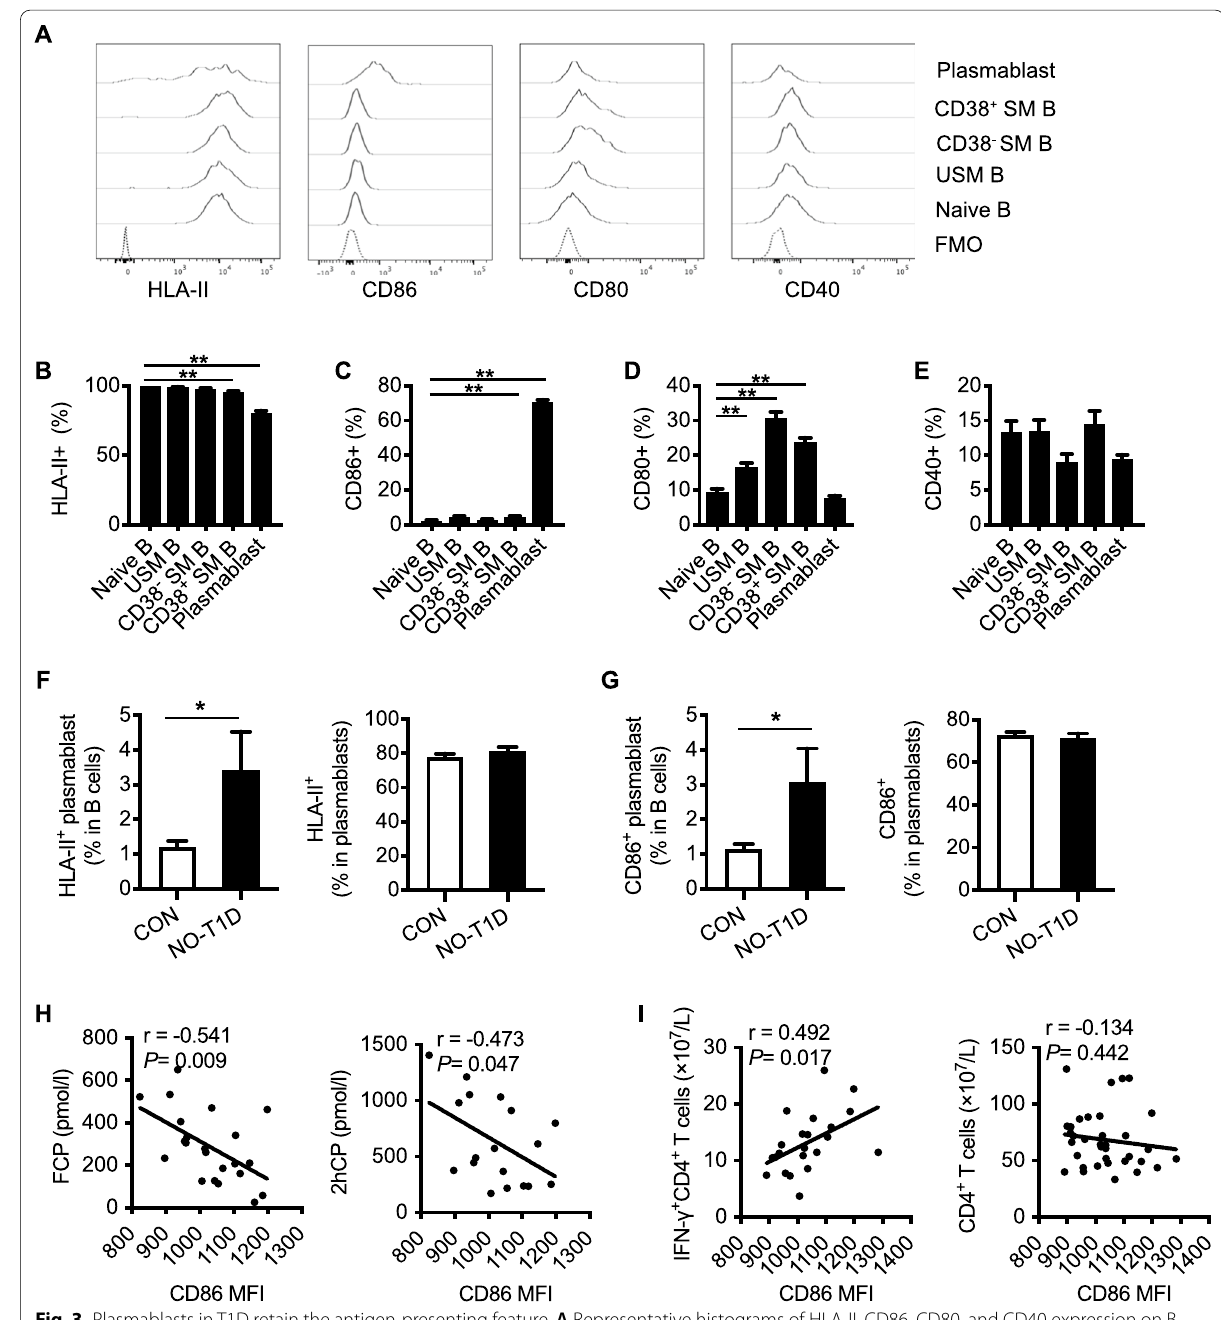
Fig. 3 Plasmablasts in T1D retain the antigen-presenting feature. A Representative histograms of HLA-II, CD86, CD80, and CD40 expression on B cell subsets from patients with new-onset T1D. B – E The analyses of the HLA-II, CD86, CD80, and CD40 expression on B cell subsets. Data indicate mean SEM. Difference between groups were assessed by One-way ANOVA followed by Dunnett’s multiple comparisons test. ** P < 0.01 compared ± with naïve B cells. F – G Comparison of the HLA-II + and CD86 + plasmablast frequencies in B cell compartment between control subjects and patients with new-onset T1D. Data indicate mean SEM. Independent t test, * P < 0.05. H Association between CD86 expression and FCP and 2hCP ± in patients with new-onset T1D. I Association between CD86 expression on plasmablasts and IFN-γ + CD4 + T cells in patients with new-onset T1D. Correlation was assessed by Pearson analysis. FCP, plasma fasting C-peptide; 2hCP, plasma 2-h postprandial